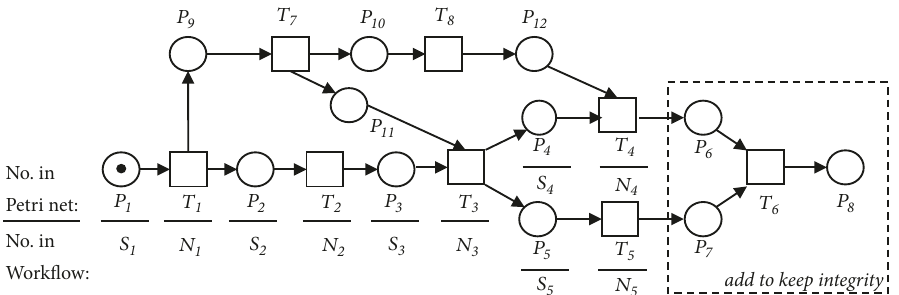
Figure 4: Petri net model of aircraft fire emergency response after